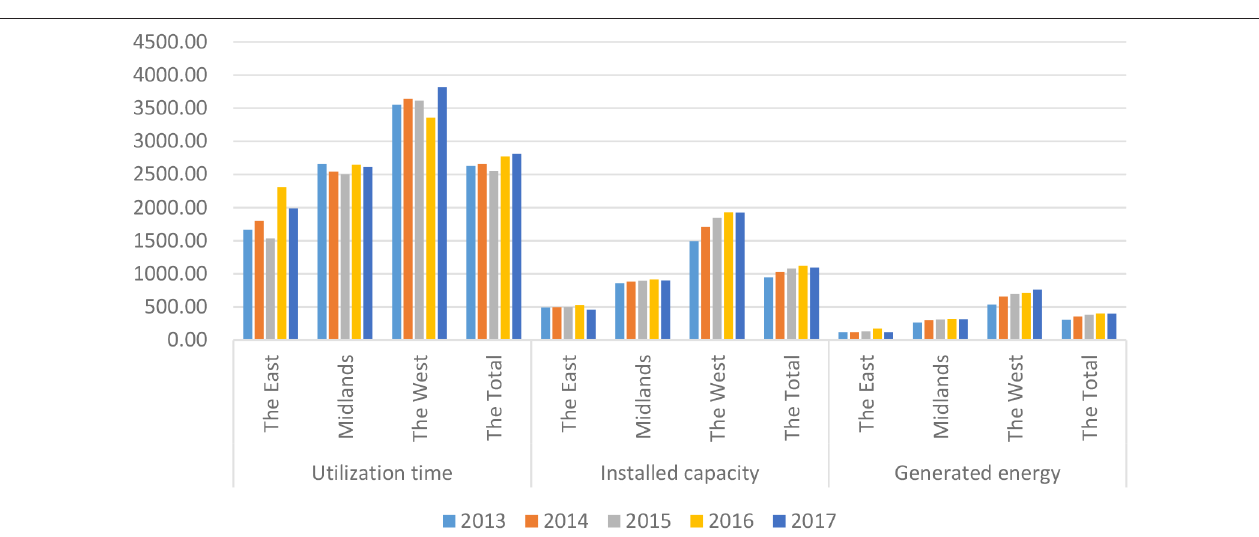
FIGURE 1 | Comparison of the average situation of each indicator by region from 2013 to 2017.